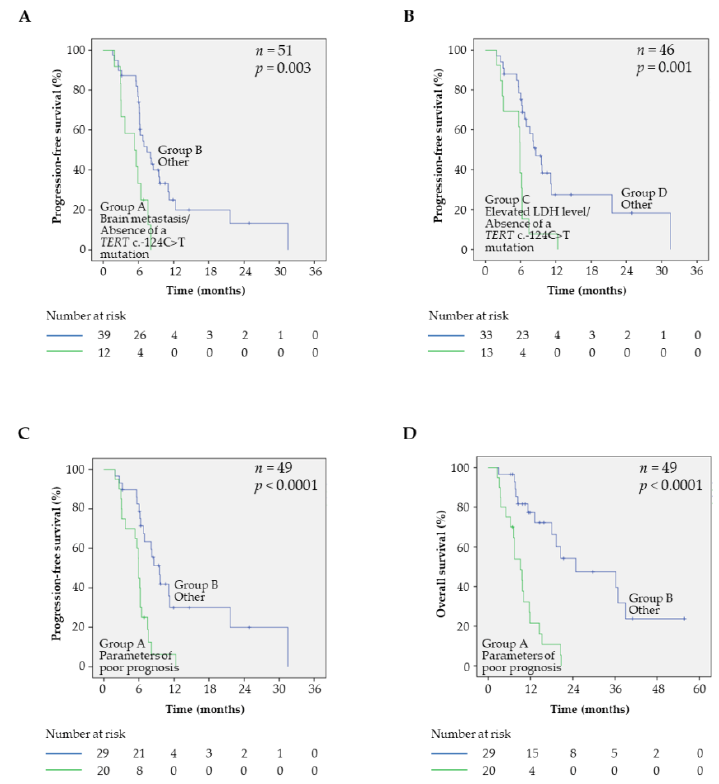
Figure 5. Prognostic value of a signature combining parameters of poor prognosis: elevated LDH level, brain metastasis, and absence of TERT c.-124C > T promoter mutation. ( A ) Kaplan–Meier analyses of PFS in patients combining brain metastasis and absence of TERT c.-124C > T promoter mutation (group A, green curve) and in the remaining patients (group B, blue curve). ( B ) Kaplan–Meier analyses of PFS in patients combining elevated LDH level and absence of the TERT c.-124C > T promoter mutation (group A, green curve) and in the remaining patients (group B, blue curve). ( C ) Kaplan–Meier analyses of PFS in patients combining parameters of poor prognosis (group A, green curve) and in the remaining patients (group B, blue curve). ( D ) Kaplan–Meier analyses of overall survival (OS) in patients combining parameters of poor prognosis (group A, green curve) and in the remaining patients (group B, blue curve).